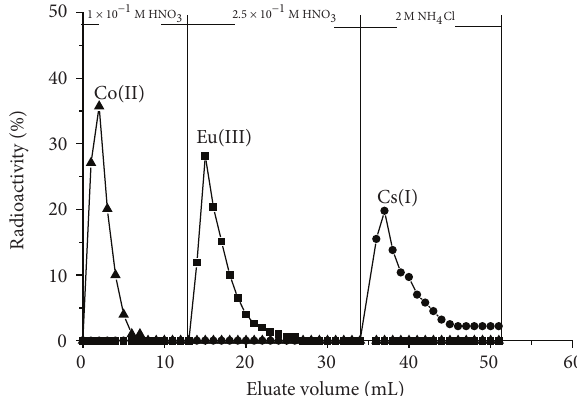
F 3: Elution pro�les of Cs(I), Eu(III), and Co(II) from 1g zirconium selenomolybdate column (0.6cm i.d.) with HNO Cl solutions, at a �ow rate NH 4